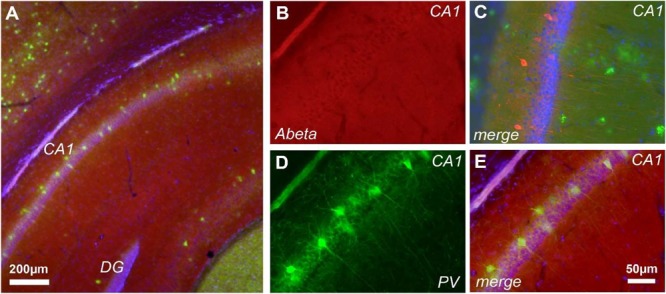
Aβ is not detected at 1-month of age in J20 mice. Immunohistochemical staining in the hippocampus of J20 mice with FCA3340 (red), PV (green) and DAPI (blue) showed no traces of Aβ in either areas of hippocampal formation (A,B,D). Accordingly, no traces of Aβ were detected coexisting with the PV+ cells (D,E). FCA3340 (green) reveals the presence of Aβ around CA1 in 5-month-old TG mice (C), n = 3, non-TG and 4, TG.